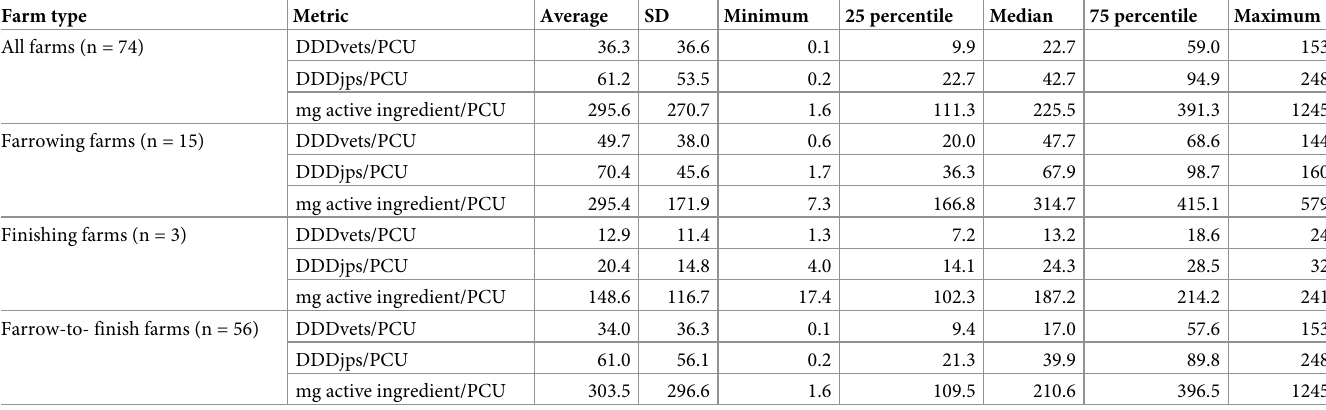
Table 5. Distribution of antimicrobial use on the 74 pig farms by farm type and metric. Farm